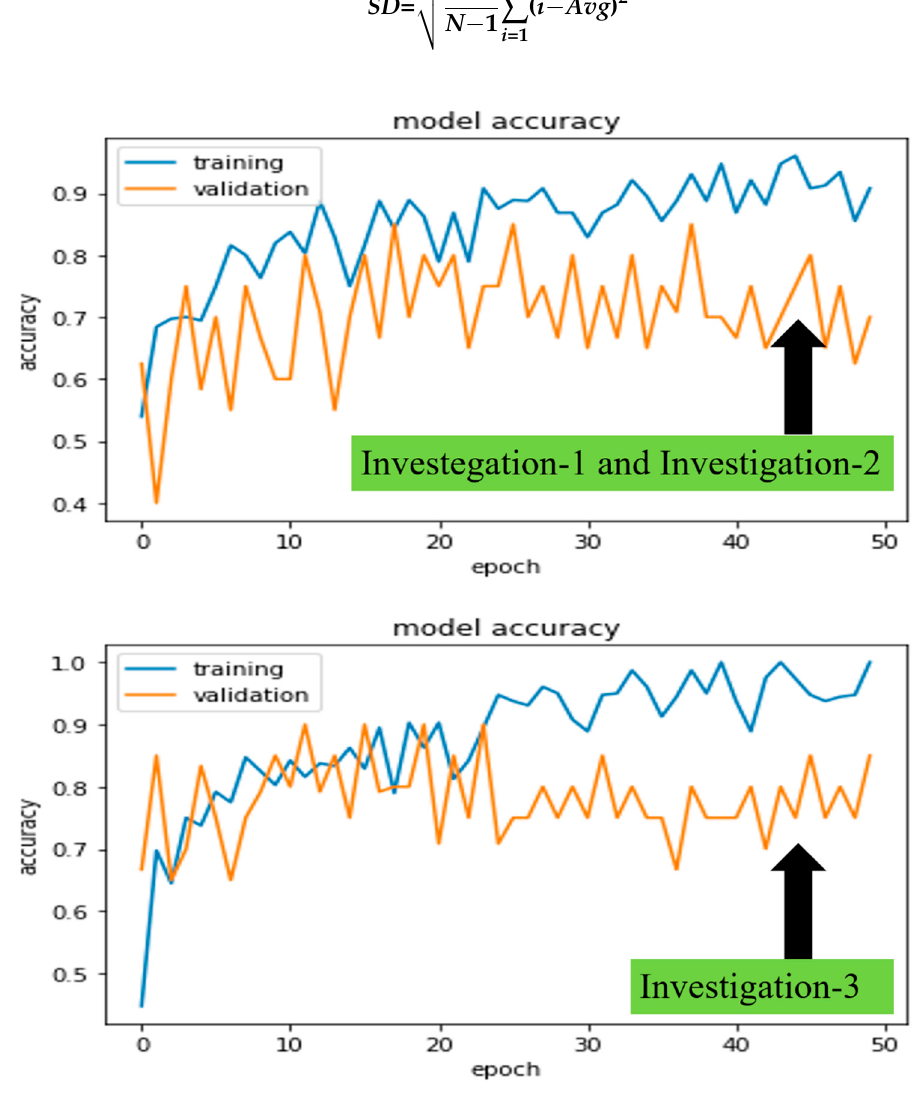
Figure 7. The CheXNet model’s training and validation accuracies in investigation-1 and 2 (on top) and investigation-3 (on bottom) per epoch.